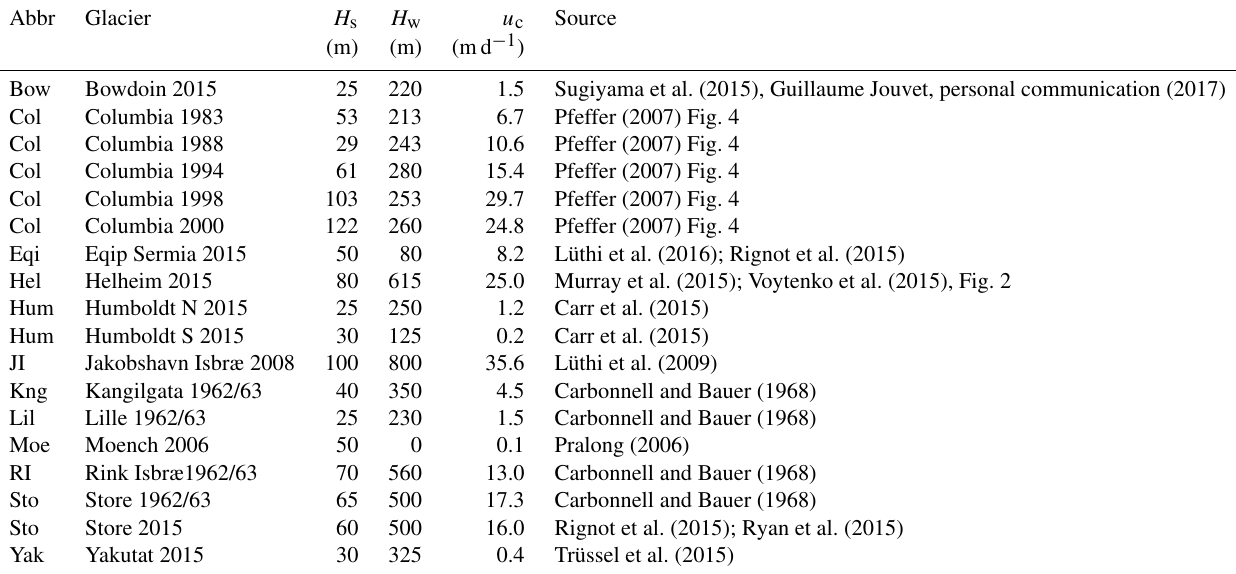
Table 5. Values of calving front height, water depth and calving rate for different glaciers. Abbr